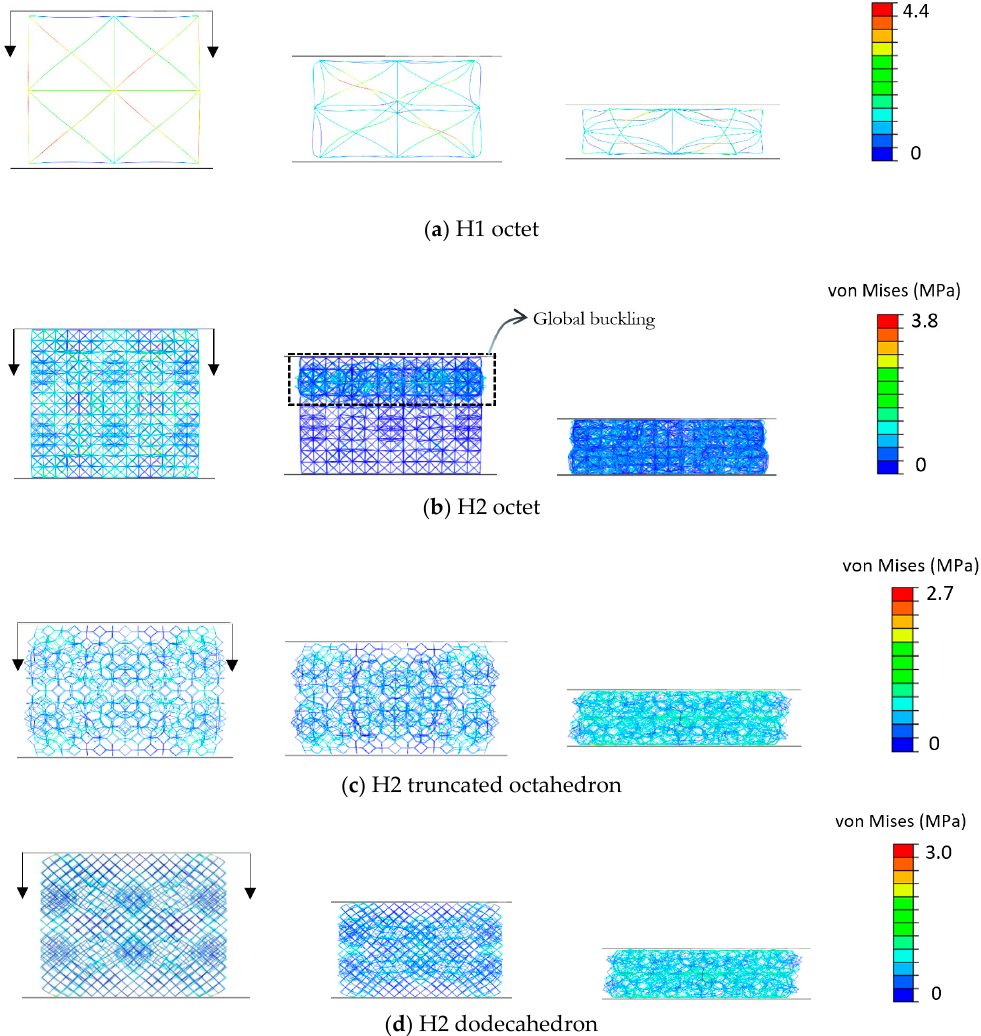
Figure 6. FEA von Mises stress contour plots for various lattices under compression of 50% overall lattice strain. ( a ) first order octet lattice, ( b ) second order octet lattice, ( c ) second order truncated octahedron lattice, ( d ) second order dodecahedron